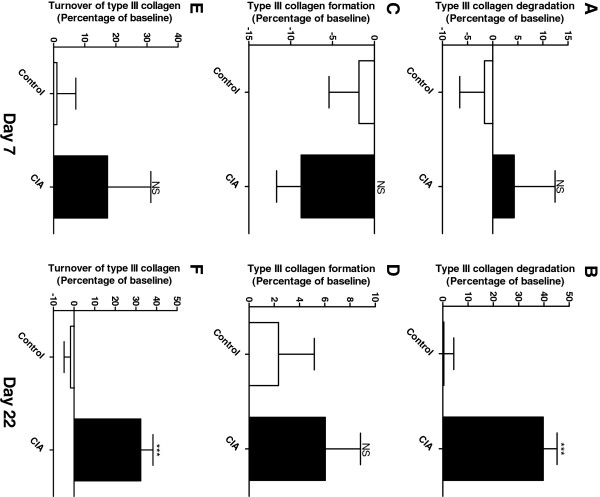
Biomarkers of type III collagen turnover on day 7 and 22 corrected to baseline. A, B: Type III collagen degradation detected with C3M. Range of measurement was [2.6-35.5]. C, D: Formation of type III collagen detected with P3NP. Range of measurement was [13.9-71.5]. E, F: Calculations of type III collagen turnover Range of measurement was [0.1-0.6]. The CIA group (black, n = 10) and control animals (white, n = 10) were compared by Mann-Whitneyt-test. All statistical analyses were calculated based on baseline corrected values. Data are shown as mean ± SEM and significance levels as *: P < 0.05, **: P < 0.01, ***: P < 0.001.